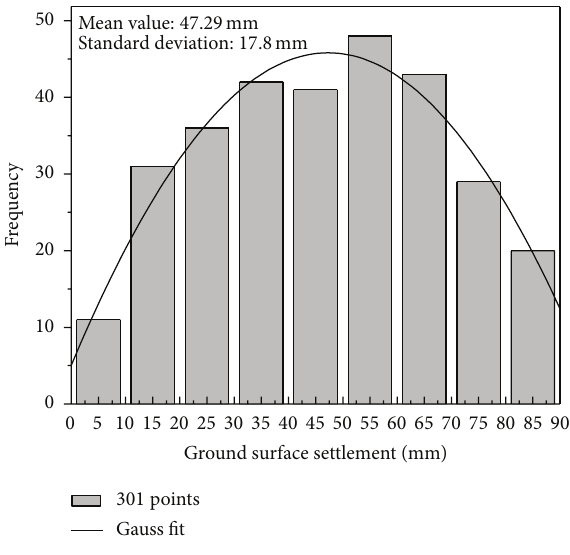
Figure 19: Statistical data of ground settlement induced by the subway station excavation.